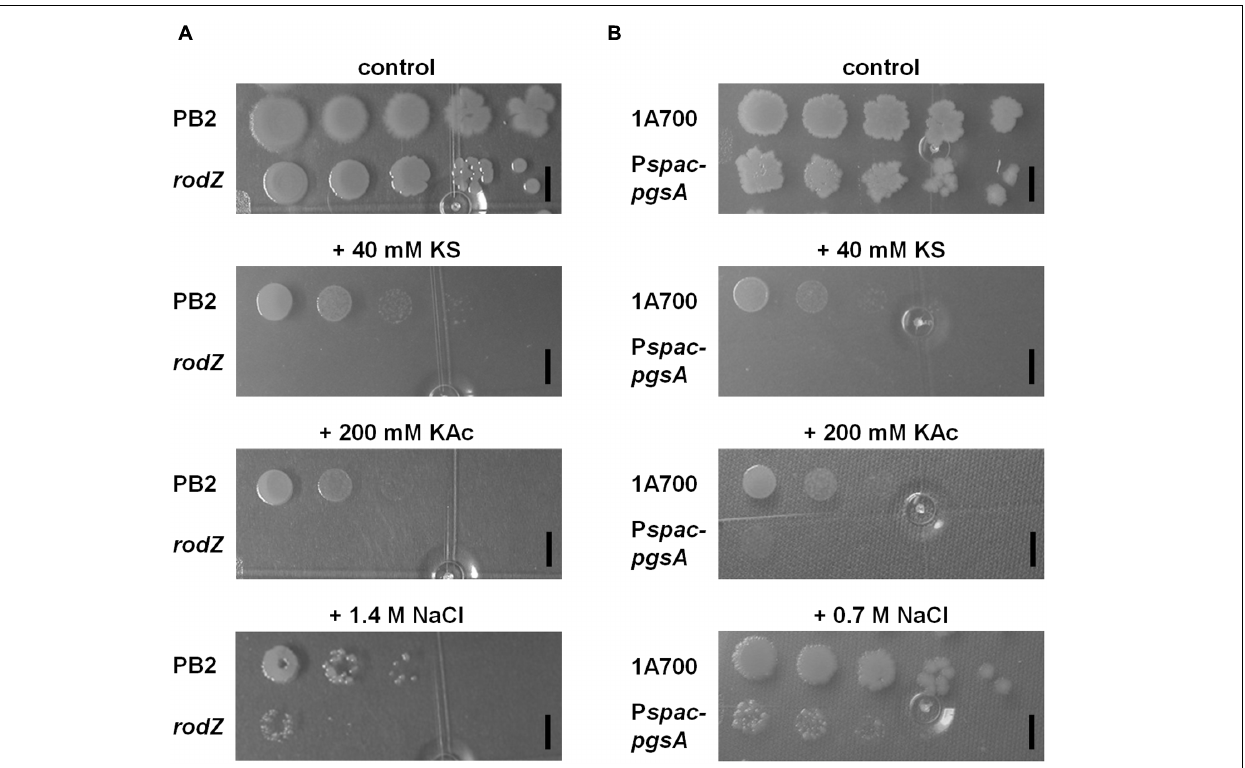
FIGURE 2 | Characterization of the rodZ transposon mutant and a conditional pgsA mutant revealed similar (hyper)sensitivity on solid plates for sorbic acid, acetic acid, and NaCl. WT (PB2), rodZ ::miniTn 10 (ATB012) (A) , and WT (1A700), pgsA ::P spac-pgsA (MHB001) (B) were grown exponentially to an OD 600 of 0.2 when 10-fold dilutions were spotted onto LB plates of pH 6.4 containing no, 40 mM KS, 200 mM KAc, 0.7, or 1.4 M NaCl. Plates were photographed after 24 h of growth at 37 ◦ C. The black bars indicate 5